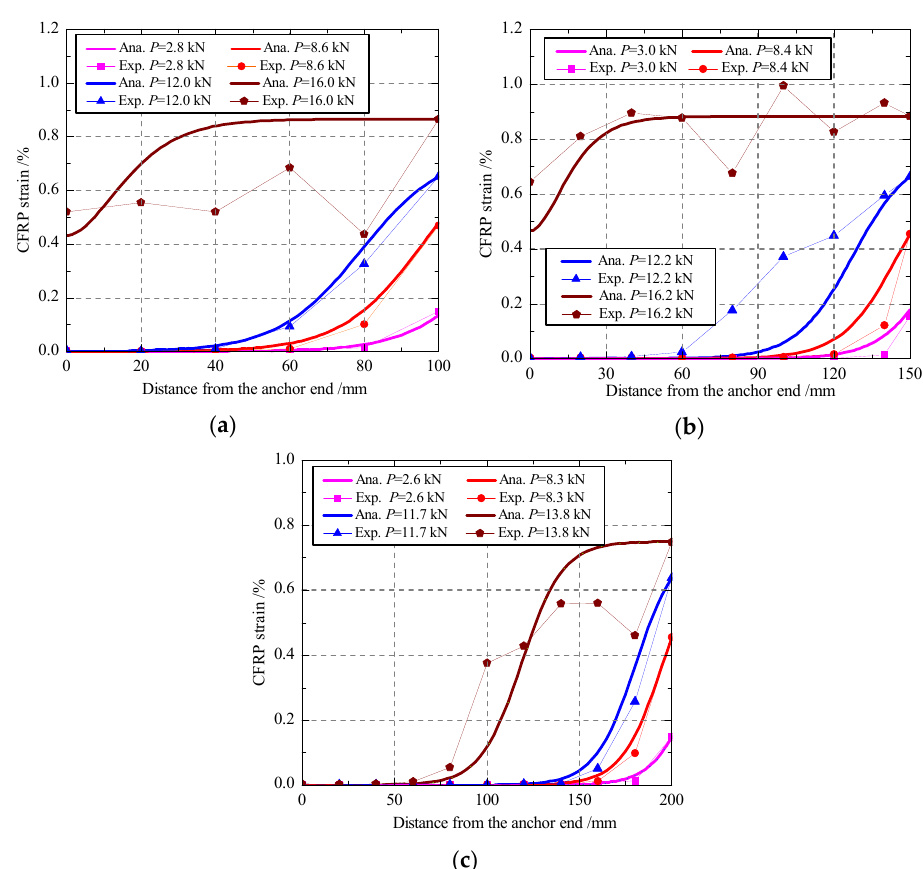
Figure 11. Distributions of the CFRP strains: ( a ) EA-100-1; ( b ) EA-150-1; ( c )EA-200-1.